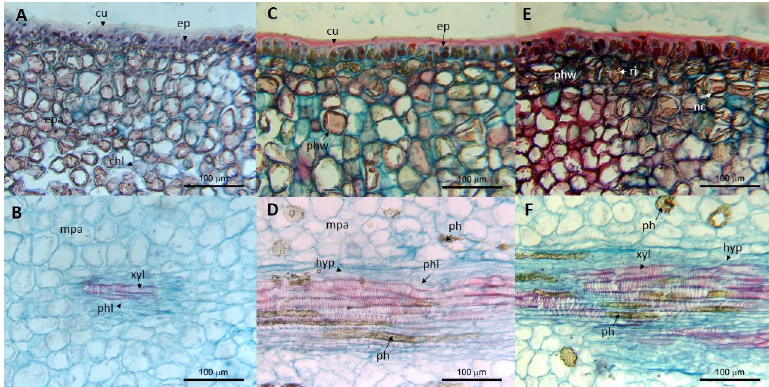
Figure 3. Cross-sectional micrographs of the exocarp and mesocarp tissues of avocado fruits infected with the avocado sunblotch viroid (ASBVd): ( A , B ) Asymptomatic; ( C , D ) yellowish sunken spot and ( D, E ) yellowish sunken crack. Cuticle (cu), epidermal cells (ep), exocarp parenchyma (epa), mesocarp parenchyma (mpa), chloroplasts (chl), phloem cells (phl), xylem vessels (xyl), phenol accumulation in cell wall (phw), hypertrophy (hyp), accumulation of red inclusions (ri), and necrotic cells (nc).